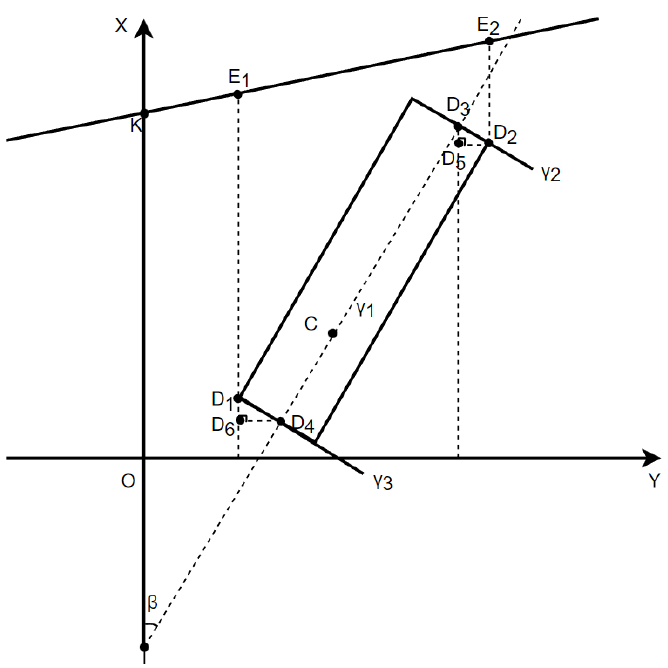
Figure 3. Projection of the ship on the bridge.